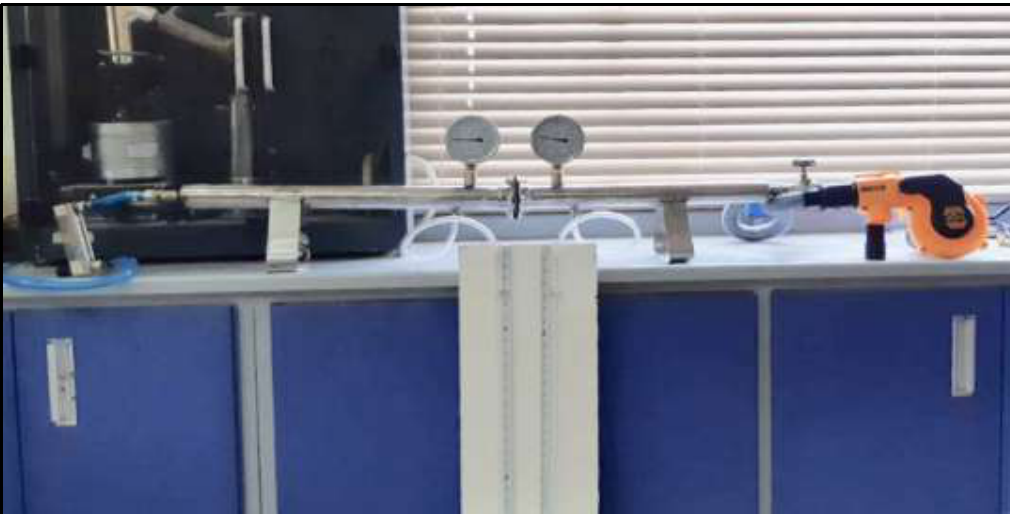
Figure 5: Photograph of the air flow system for nanofilters flow performance